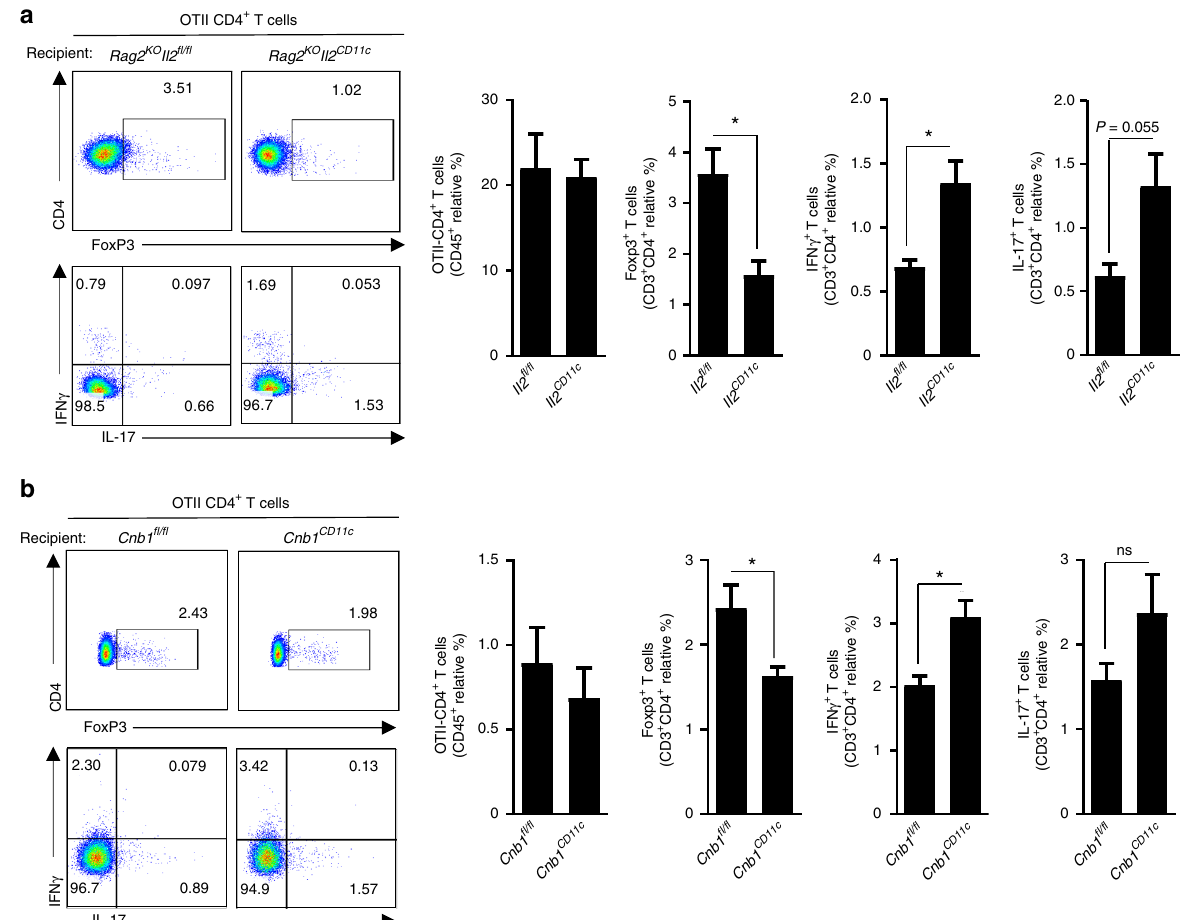
Fig. 8 Il2 or Cnb1 de fi ciency in DCs causes a dysregulated T-cell response. a , b Naïve congenic OTII cells were sorted from spleens of donor mice and transferred intravenously into Rag2 KO Il2 fl / fl and Rag2 KO Il2 CD11c ( a ) or Cnb1 CD11c and Cnb1 fl / fl mice ( b ). After 24 h, mice were administered OVA protein antigen by daily oral gavage for 5 days. The frequencies of CD4 + T cells expressing FoxP3, IL-17, and IFN γ were examined in the mesenteric lymph node 7 days after adoptive cell transfer. Representative FACS plots of OTII donor CD4 + T cells are shown (left panels). Data represent the means ± standard deviation of two experiments ( n = 1 – 2 mice/group). * P < 0.05 (two-tailed, unpaired Student ’ s t